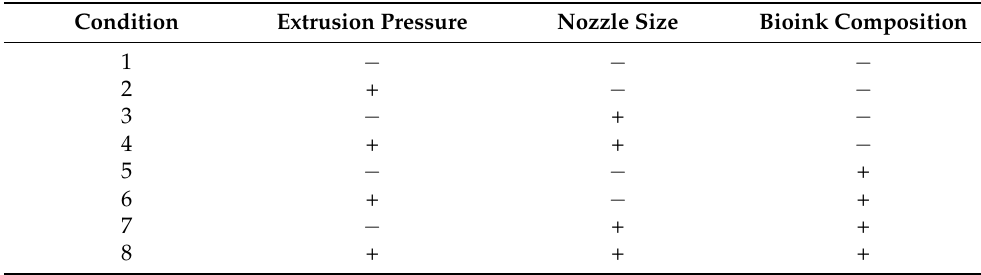
Table 2. Matrix of Table 2. Matrix of experiments.